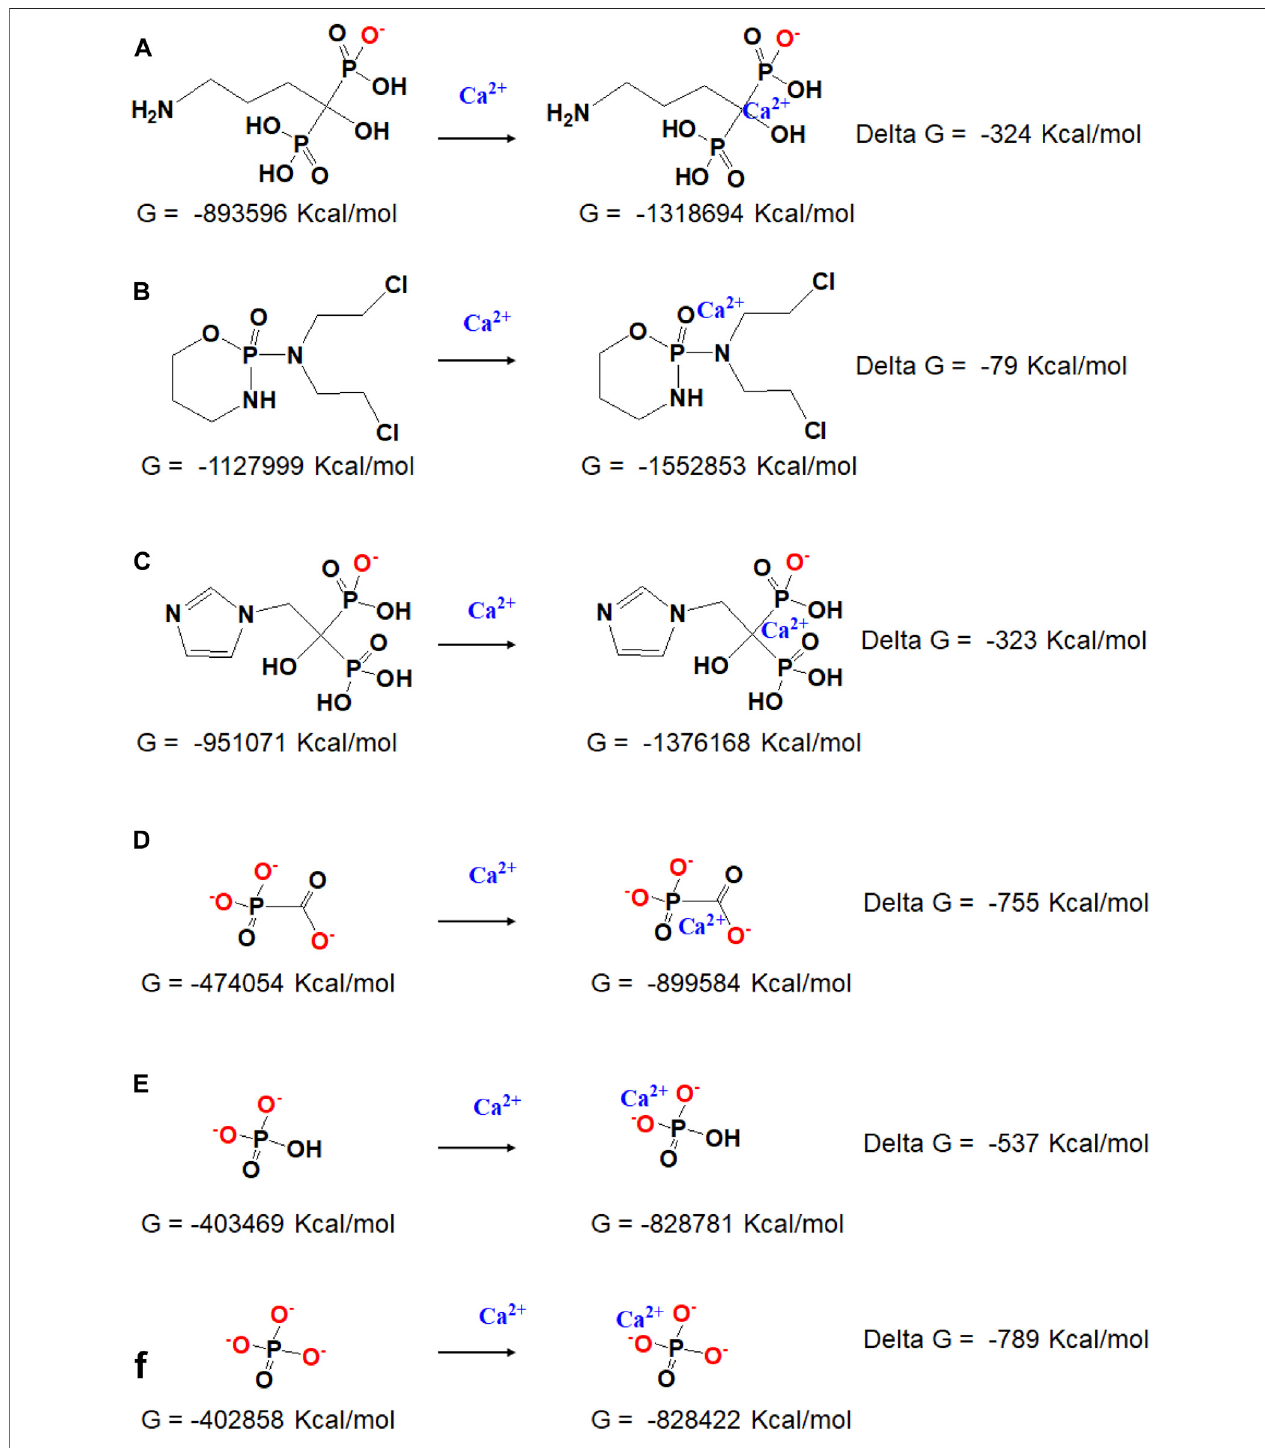
FIGURE 2 | Chemical structural formula and the responding Gibbs free energy of (A) Adn − and Adn − + Ca 2+ , (B) Cpp and Cpp + Ca 2+ , (C) Zda - and Zda − + Ca 2+ , (D) Fss 3- and Fss 3- + Ca 2+ , (E) HPO 42- and HPO 42- + Ca 2+ , and (F) PO 43- and PO 43- + Ca 2+ .